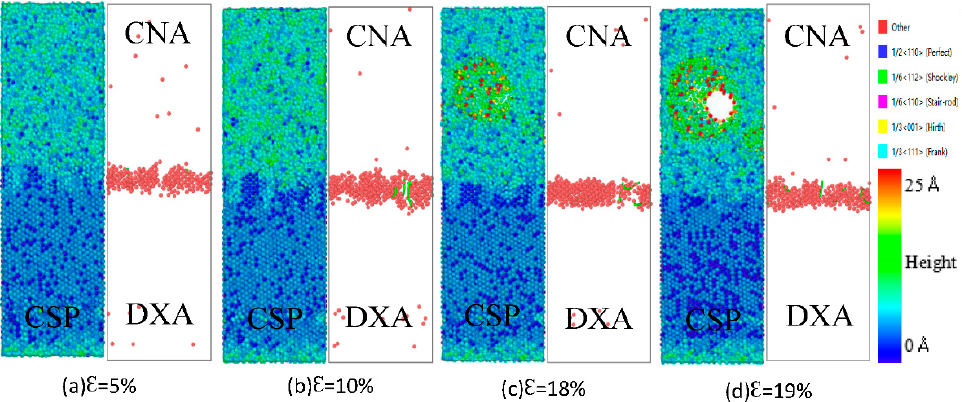
Figure 15. Atomic CSP, CNA, and DXA analysis of the Fe (110)/Cu (110) diffused interface under z-axis tensile process at 500 K.